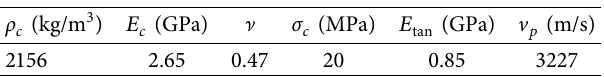
Figure 2: The model with cement mortar, including an in situ stress loading system and data acquisition system: (a) ZDF-3 electric spark source; (b) blast hole with water seal; (c) steel pipe; (d) eight-channel ultradynamic data acquisition machine (DH5930); (e) prestressing anchorage; (f) center hole jack; (g) ZB-500 electric fuel pump; (h) strain brick. Table 1: The physical and mechanical parameters of cement mortar